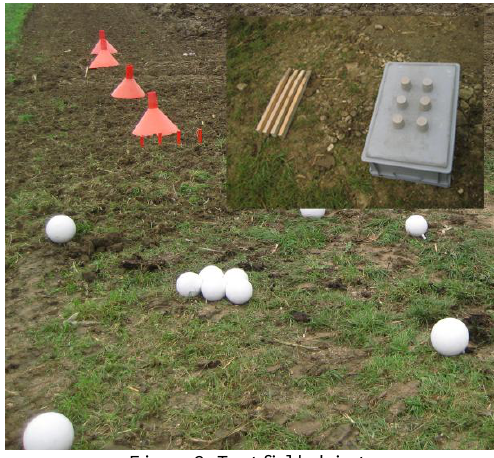
Figure 2: Test field objects